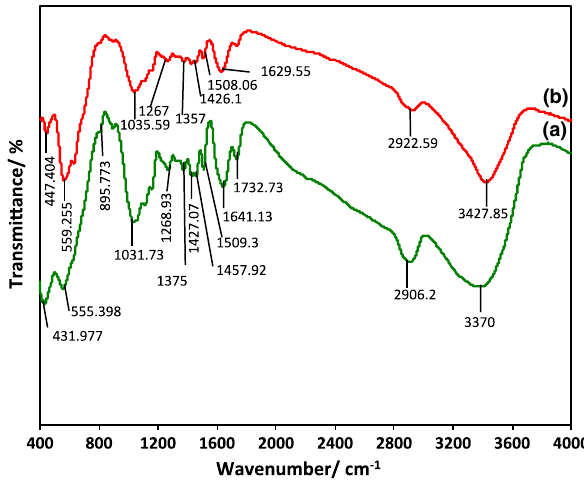
Fig. 4 FTIR spectrum of SF-(1:2) composite a fresh sample and b after adsorption after adsorption